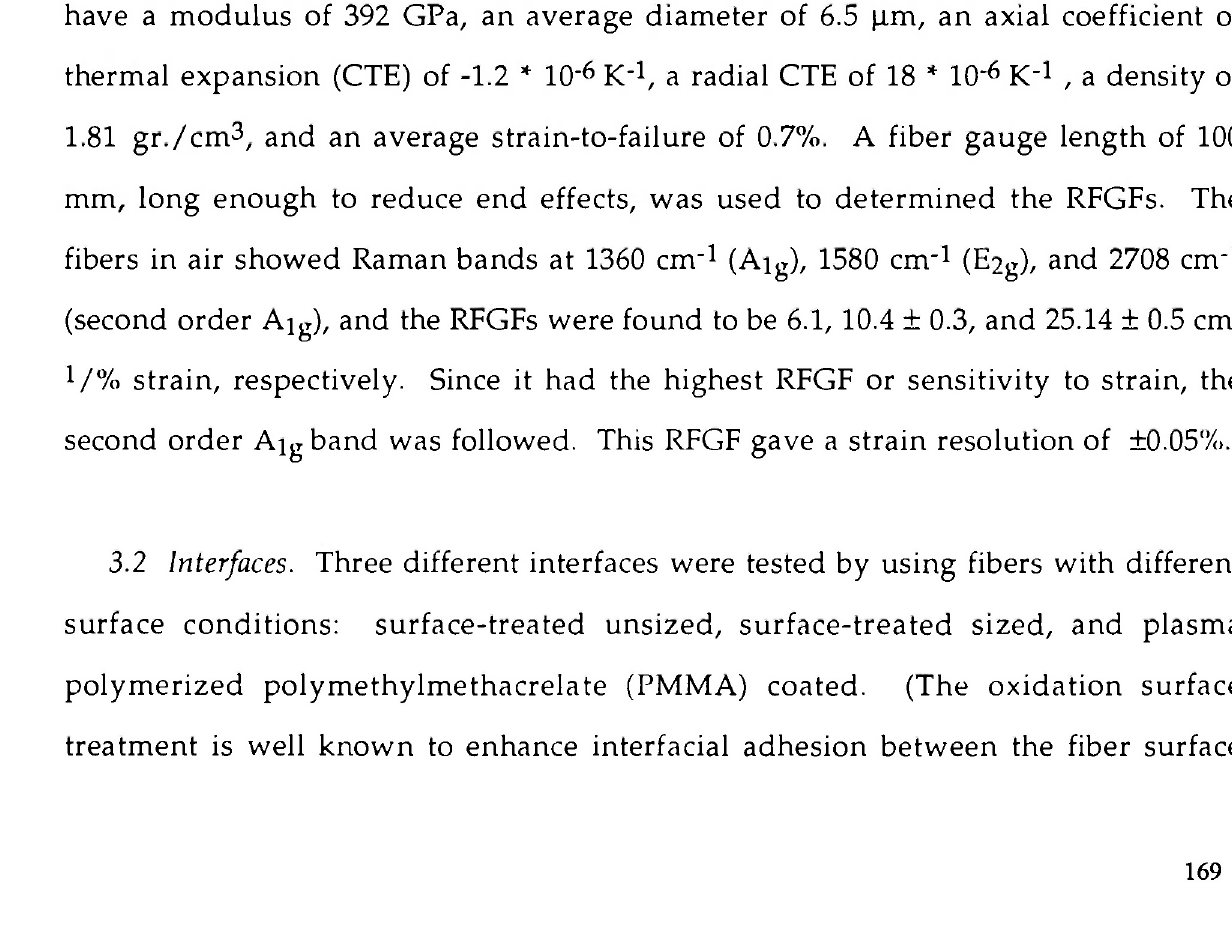
Strain (%) Fig. 6: The tensile stress-strain curve of the bulk matrix material, Shell Epon 828 based on diglycidyl ether of